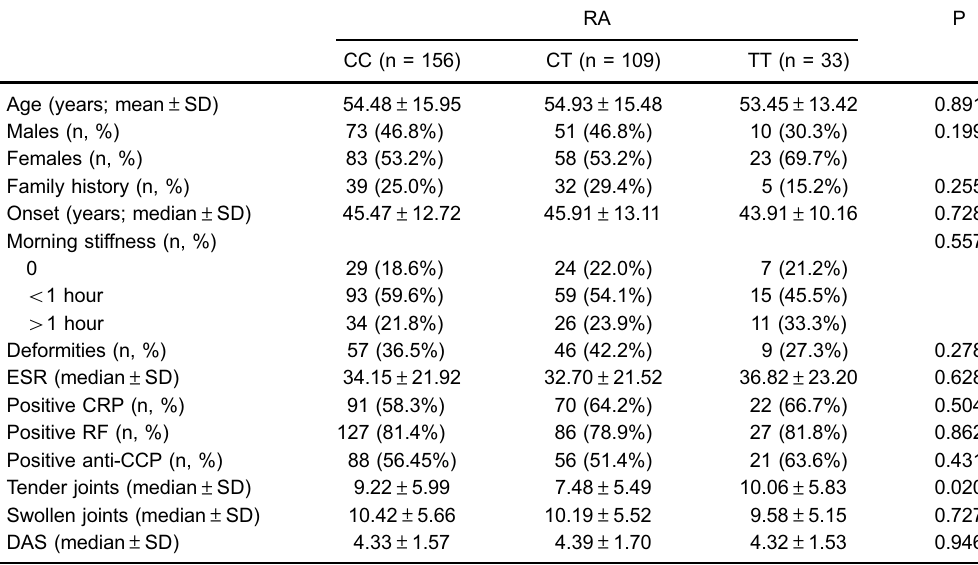
Table 4. Comparison of studied data according to autoimmune regulator (AIRE) gene genotypes in all rheumatoid arthritis (RA) cases.